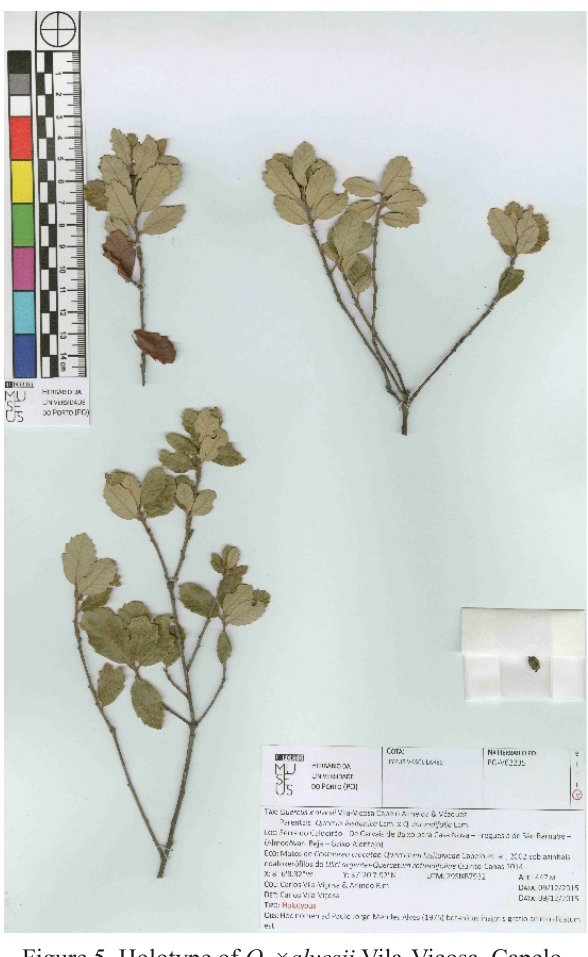
Figure 5. Holotype of Q. × alvesii Vila-Viçosa, Capelo, R. Almeida & F.M. Vázquez nothosp.nov. PO-V62235! (Porto University, Natural History and Science Museum).